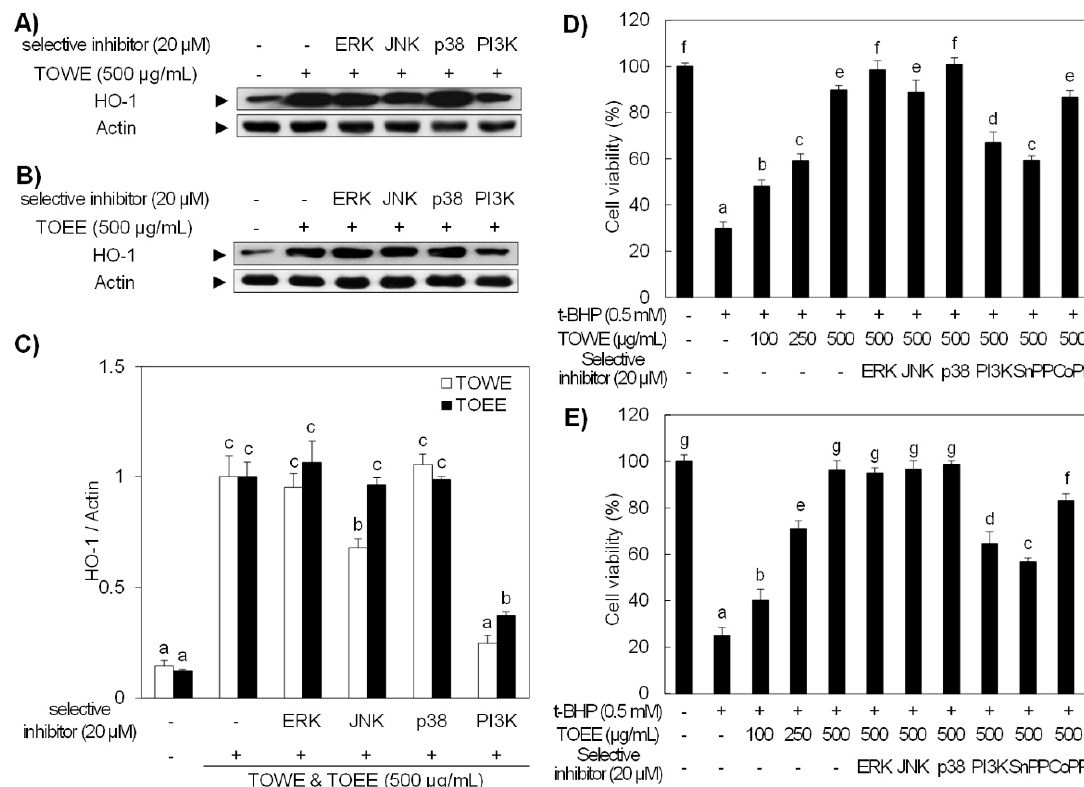
Figure 4. TOWE and TOEE induced HO-1 expression was abolished by the treatment of selective inhibitors, which was confirmed by t-BHP-induced oxidative damage in RAW 264.7 cells. ( A and B ) RAW 264.7 cells were treated with 20 μ M of selective inhibitors for PI3K/Akt and MAPK signaling molecules in the presence of 500 μ g/mL of TOWE and TOEE. The selective inhibitors for JNK and PI3K attenuated TOWE-induced HO-1 expression, while TOEE-induced HO-1 expression was only abolished by a PI3K selective inhibitor. The HO-1 protein expression was analyzed by Western blot analysis. ( C ) The relative induction of HO-1 was quantified by densitometry, and actin was used as an internal control. ( D and E ) The antioxidative potential of TOWE and TOEE scavenged the t-BHP-induced oxidative damage in RAW 264.7 cells. RAW 264.7 cells were treated with various concentrations of TOWE or TOEE for 12 h in the presence or absence of each selective inhibitor or inducer. The cells except untreated were exposed to 0.5 mM t-BHP for 3 h. The data represent the mean ± standard deviation of triplicate experiments. The values sharing the same superscript are not significantly different at p < 0.05 by Duncan’s multiple range test. t-BHP, tert-butyl hydroperoxide; SnPP, tin protoporphyrin; CoPP, cobalt protoporphyrin; PI3K, phosphoinositide 3-kinase.